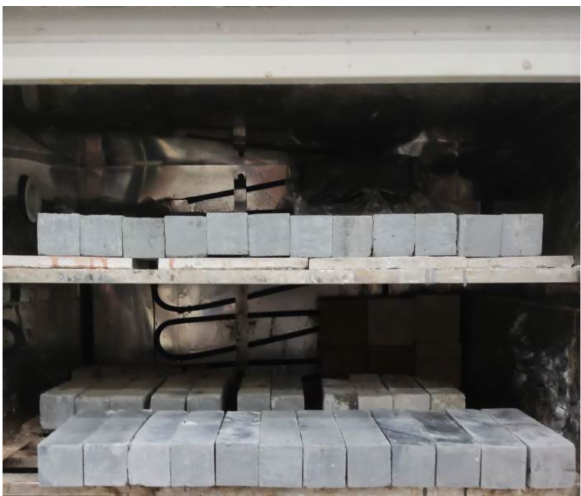
Figure 4. UHPC in the standard curing